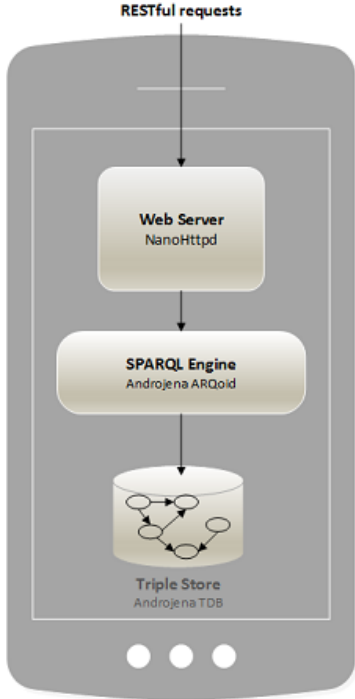
Figure 5. AndroCon Web Service